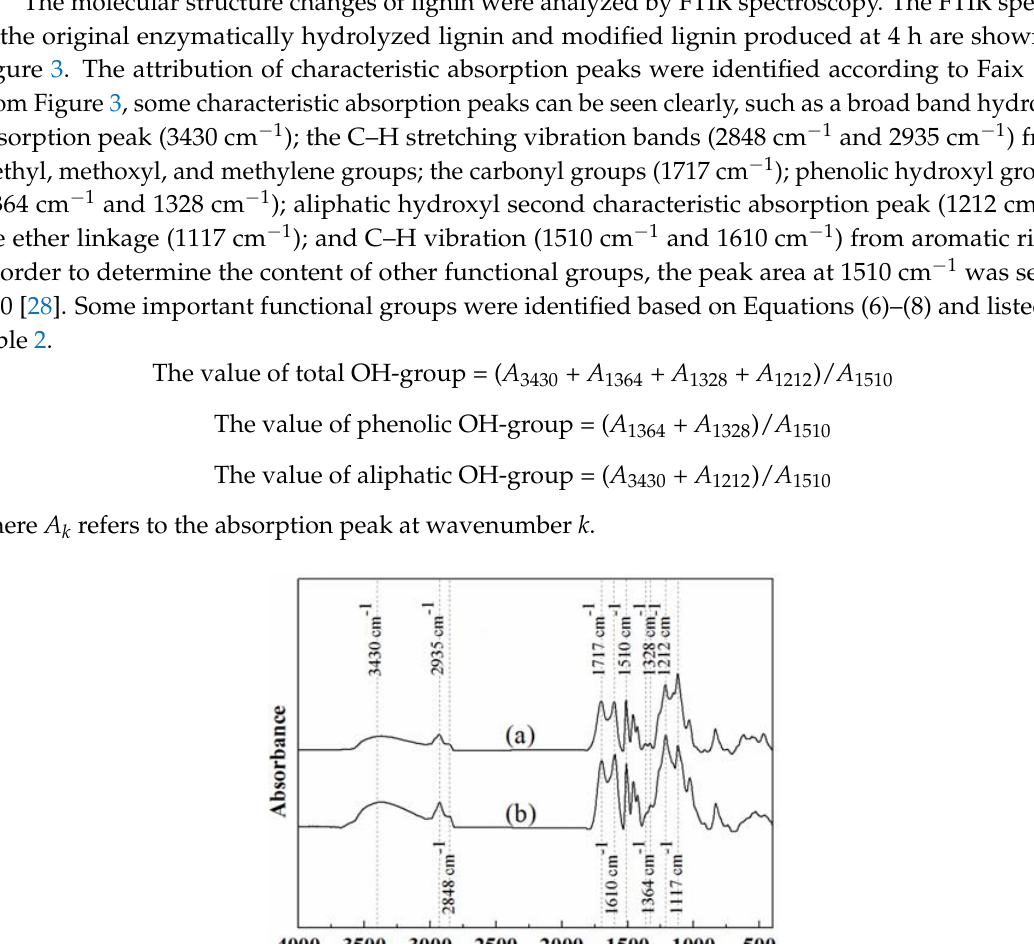
Figure 2. Total content of hydroxyl groups of lignin treated with glyoxal at different reaction times.